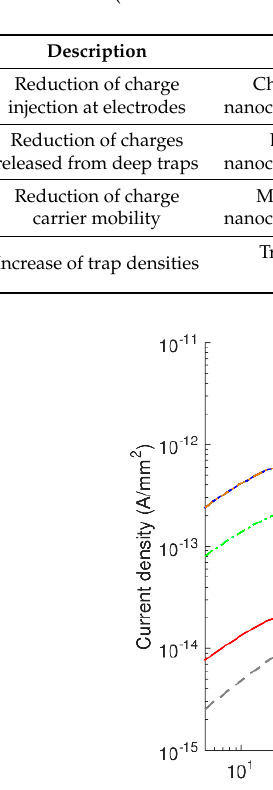
Table 2. Scenarios for simulations with varying parameters. Model parameters of each scenario are the same as for simulating charge transport in LDPE, except for those provided in the right column.